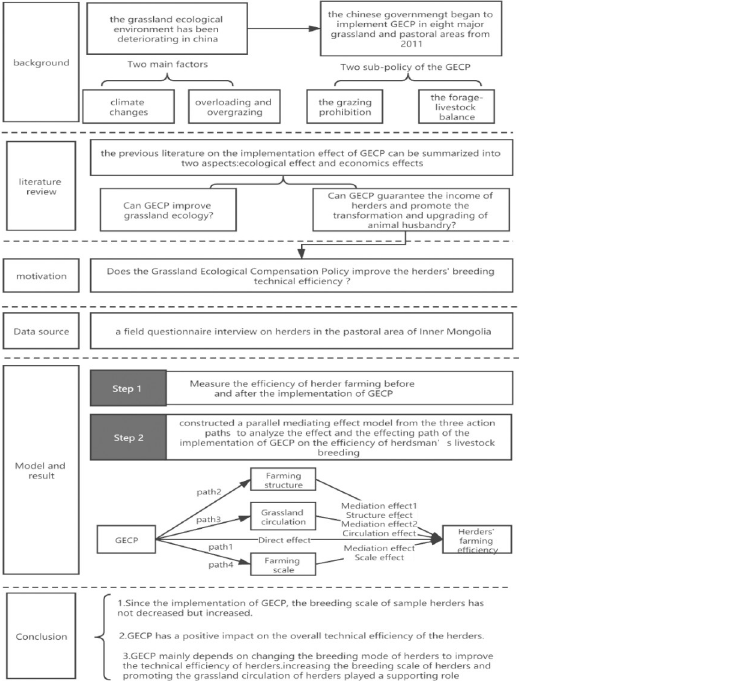
Fig 1. The framework of the